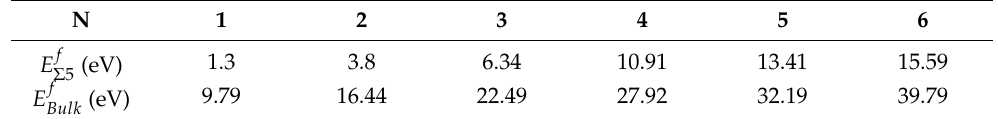
Table 2. Formation energies of Xe atoms at the GB and in the bulk UO 2 .